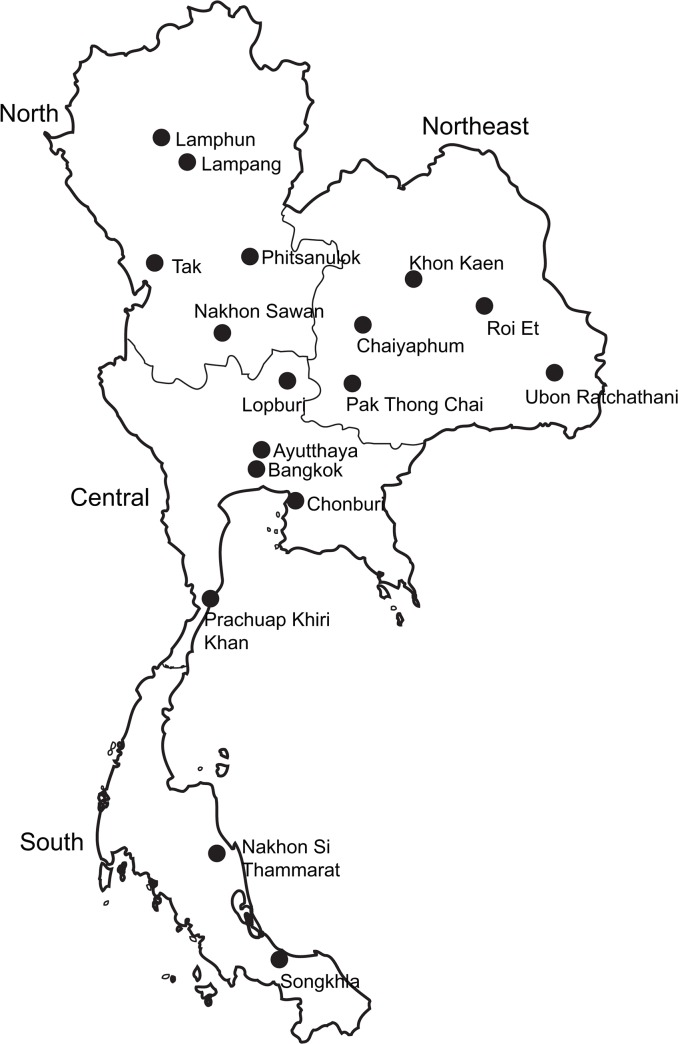
A nationwide community-based endoscopic survey of different regions of Thailand.Consecutive patients (n = 1,546) with dyspepsia were enrolled from the North, Northeast, Central, and South regions.